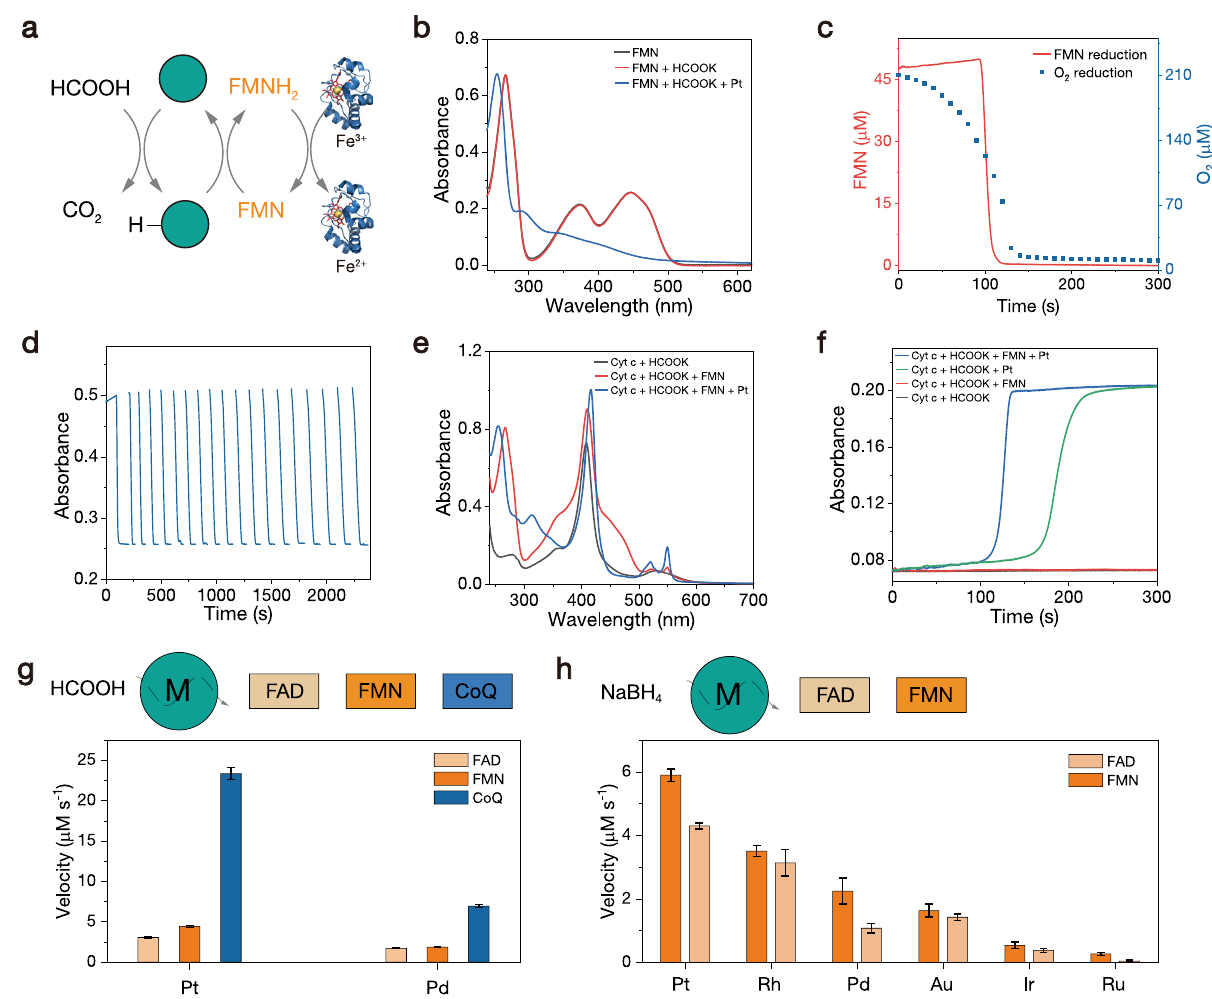
Fig. 4 Coenzyme reduction. a Schematic illustration of electron transfer from formic acid to FMN and Cyt c mediated by NPs. b UV – Vis absorption spectra of FMN, FMN + HCOOK, and FMN + HCOOK + Pt after reacting for 5 min. c The concentrations of FMN and O 2 versus time in the presence of HCOOK and Pt. d Repeated reduction and oxidation of FMN by HCOOK + Pt and air, respectively. e UV – Vis absorption spectra of different sample solutions after reacting for 5 min. f Kinetic curves of UV – Vis absorbance over time at 550 nm during Cyt c reduction under different conditions. g Catalytic performances of NPs for electron transfer from formic acid to coenzymes. h Catalytic performances of NPs for electron transfer from NaBH 4 to coenzymes. All experiments were conducted in PBS (50 mM, pH = 7.4). Error bars represent standard deviation from three independent